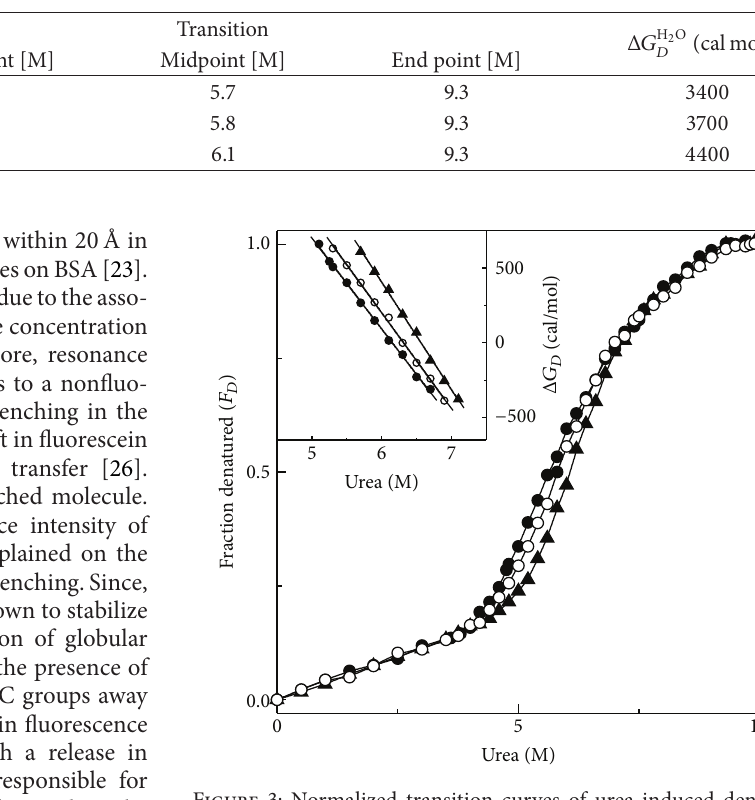
Table 1: Characteristics of urea denaturation of FITC-BSA in the absence and presence of different honey concentrations as monitored by FITC fluorescence upon excitation at 495 nm.